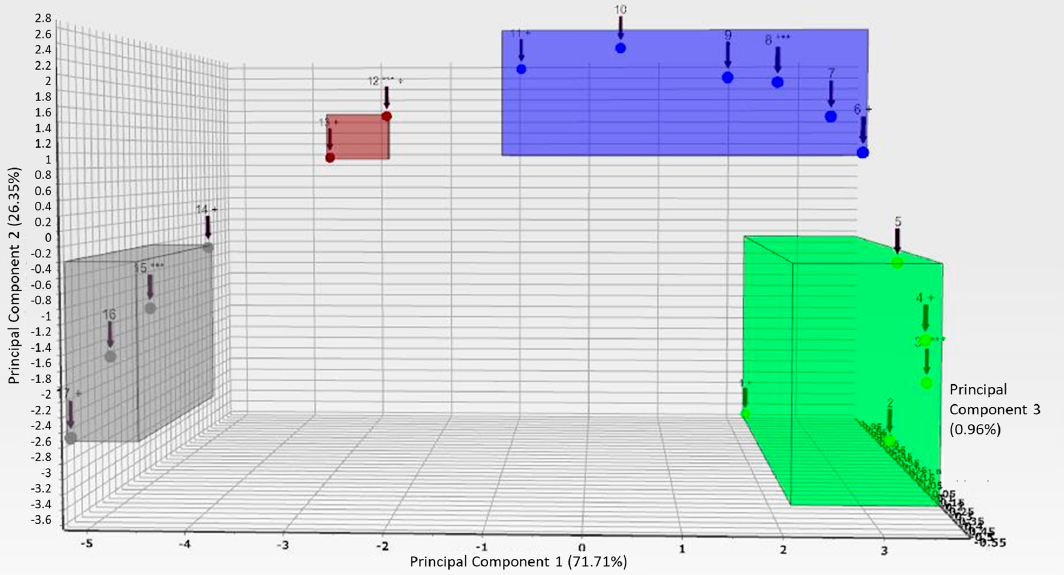
Figure 22. Clustering of XRD patterns of lepidolite–quartz mixtures. *** most representative sample of cluster, + are the most different ones in the clusters.